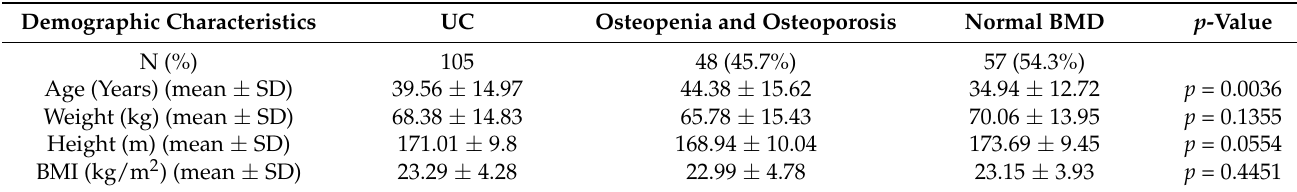
Table 3. The demographic and anthropometric parameters of the studied UC patients with respect to osteoporosis and osteopenia.